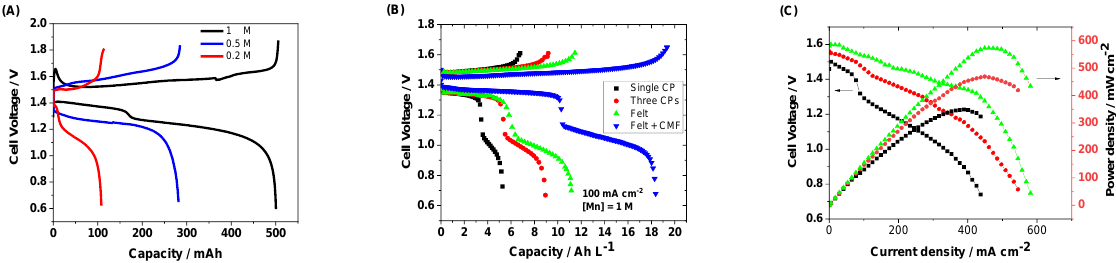
Figure 3. ( A ) Galvanostatic charge and discharge of three carbon paper (CP) electrodes in H/Mn for different manganese electrolyte concentrations. 0.2 M (red), 0.5 M (blue) and 1 M (black). ( B ) H/Mn RFB capacity over five cycles for carbon paper electrodes (one (black) and three layers (red)) compared with a single graphite felt electrode (green). Additionally, the cell capacities are compared with that using a single graphite felt combined with a single CMF as the positive electrode (blue). The electrolyte used was 1 M MnSO 4 , and 1 M TiOSO 4 in 3 M H 2 SO 4 . Hydrogen flow rate = 50 mL min − 1 , except where stated. ( C ) H/Mn polarization and power density curves for CP (black), felt (red), and CMF + felt (green) positive electrodes.